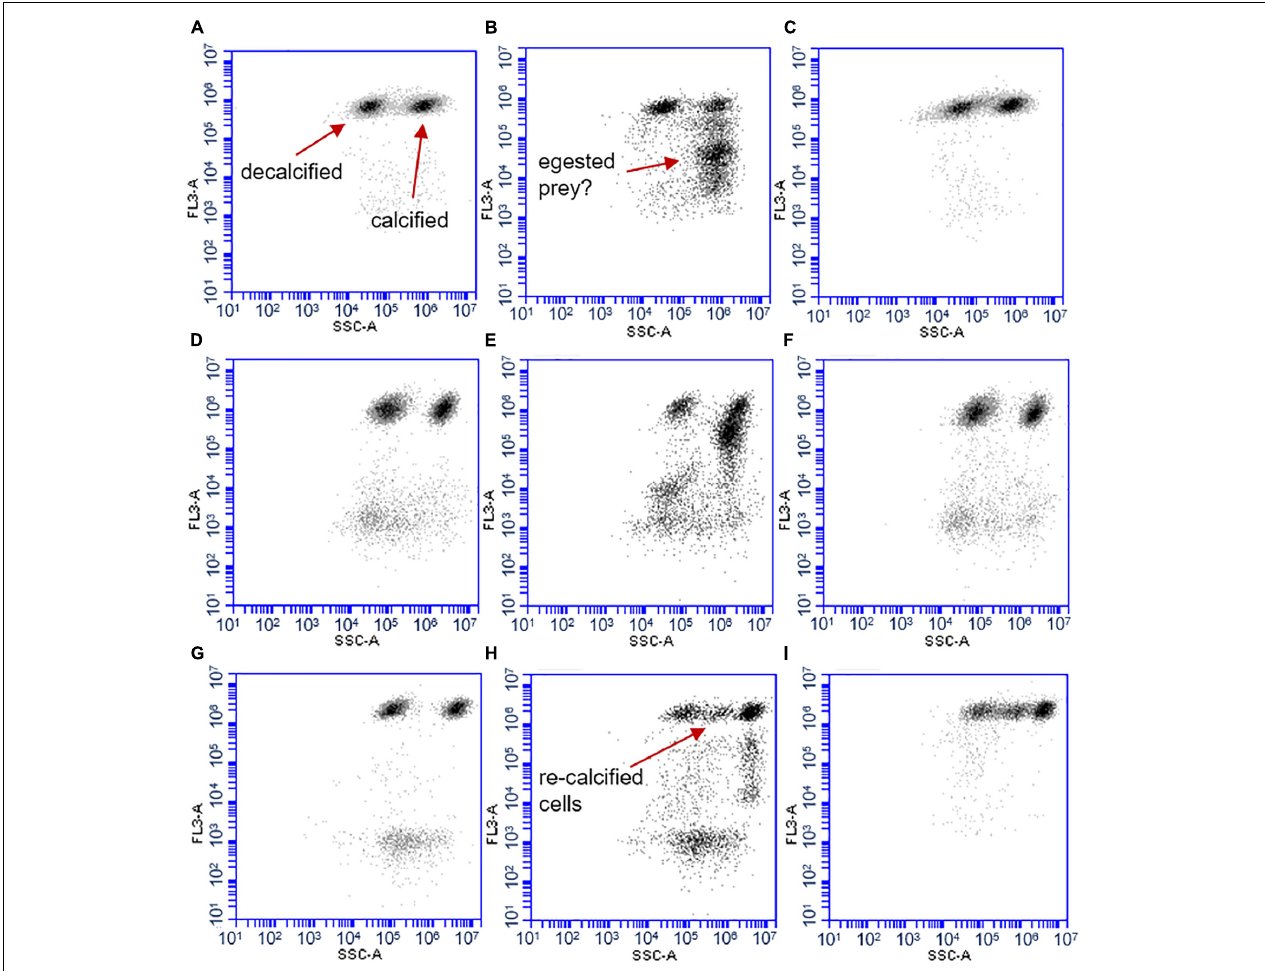
FIGURE 3 | Cytograms of mixed cultures that contained both, decalcified and calcified coccolithophores. Decalcified coccolithophores display lower side-scatter signals (SSC-A on the x-axes, strength of the signal without unit) than the calcified cells (FL3-A on y-axes = red fluorescence). Cytograms of an E. huxleyi culture with grazers (A) at the start, (B) after 24 h, (C) control without grazers after 24 h. (D) P. carterae at start, (E) after 24 h, (F) , control after 24 h. (G) G. oceanica start (H) after 72 h (I) , control without predators after 72